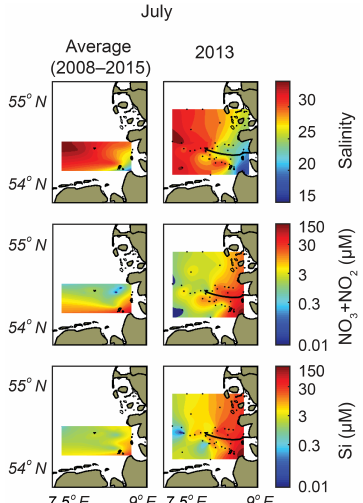
Figure 12. Same description as in Fig. 10, for the month of Au- gust. The left panels show average parameter distributions in Au- gust, based on 7 years of data (2008–2015, excluding 2013) from BAH AWI stations (Table 1); the right panels show interpolated pa- rameters from 6 to 12 August, 2013, measured at BAH AWI, BSH, FerryBox and HPA stations (Tables 1 and